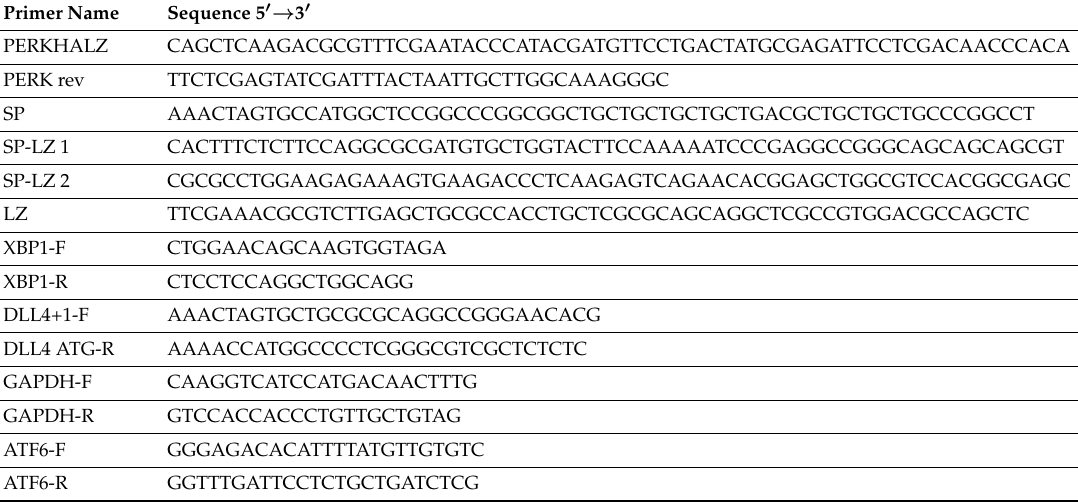
Table 1. Oligonucleotide